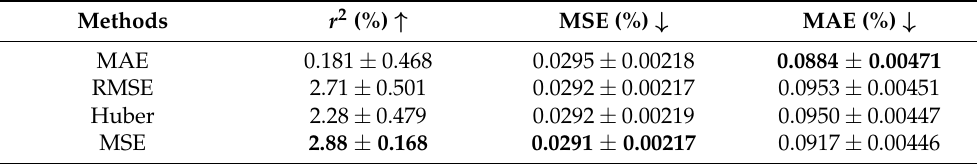
Table 5. Performances of FDG-Trans with different losses. The results are trained based on MSE loss